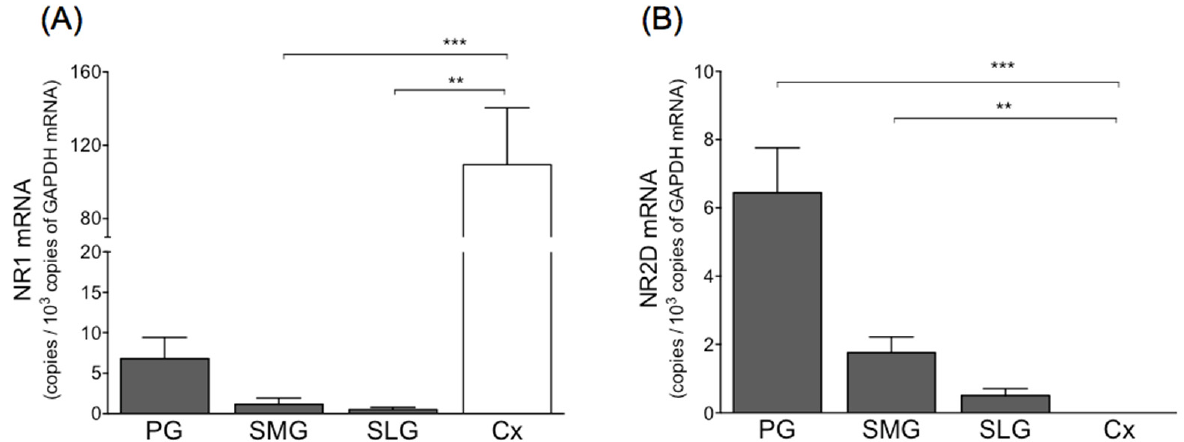
Figure 4. mRNA levels of NR1 ( A ) and NR2D ( B ) in three salivary glands and cerebral cortex in rat. Values represent mean ± SD in 6 rats. Significantly different from cerebral cortex according to Dunn’s post hoc test following Kruskal–Wallis test; ** p < 0.01, and *** p < 0.001. PG, parotid gland; SMG, submandibular gland; SLG, sublingual gland; Cx, cerebral cortex.